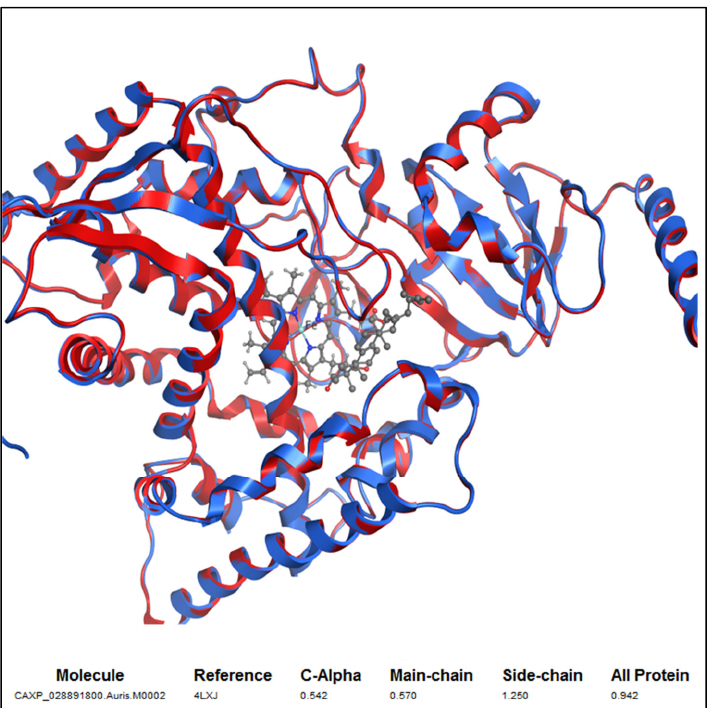
Figure 9. Alignment of the 3D model C. aurus colored in red with X-ray crystal structure of S. cerevisiae 14- α demethylase bound with lanosterol PDB: 4LXJ colored in blue. Total protein sequence alignment RMSD equal 0.942 using 4LXJ as a reference.